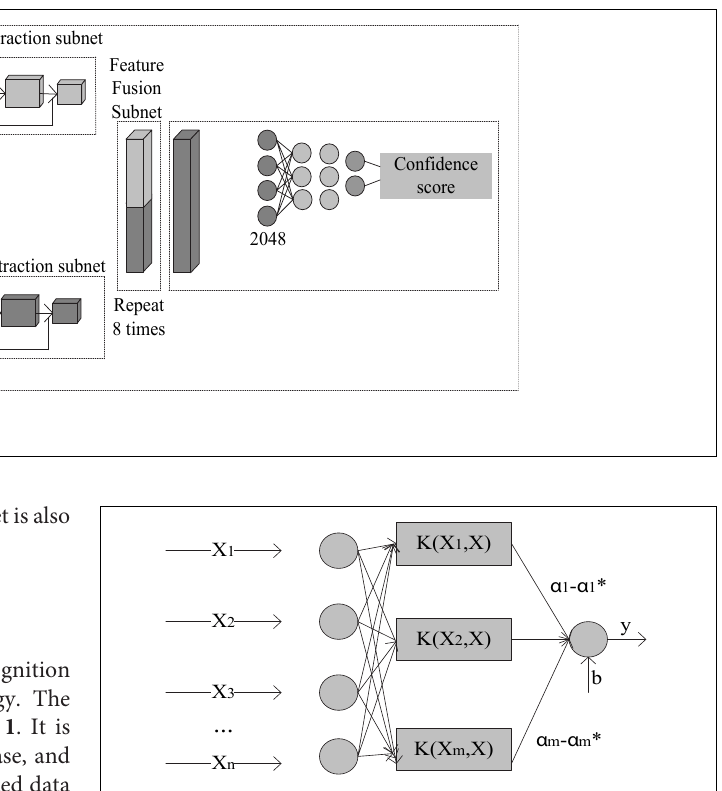
FIGURE 2 | Support vector machine model